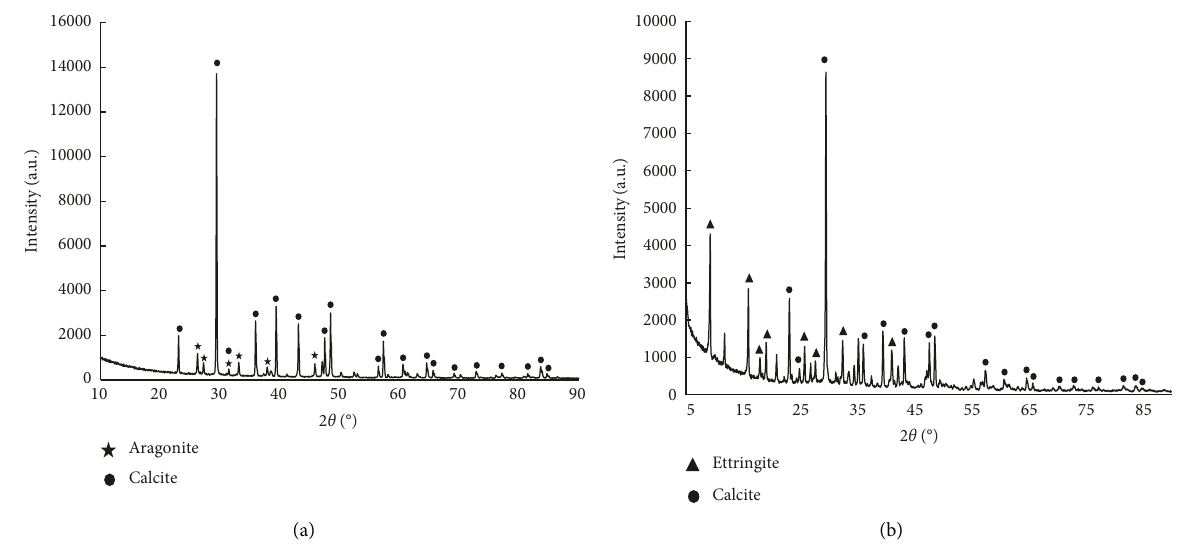
Figure 3: XRD of two samples. (a) Sample 1. (b) Sample 16.